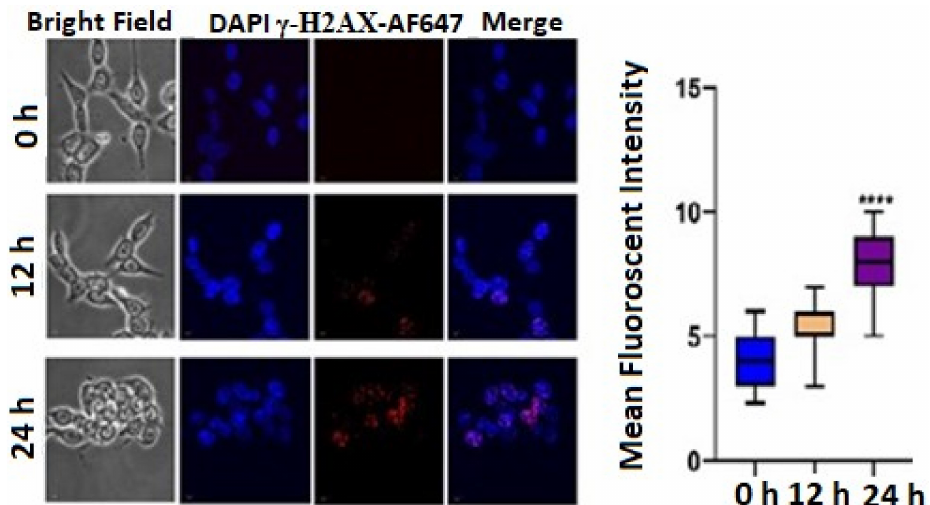
Figure 5. Immunofluorescence images showing qualitative expression of γ -H2AX expression after treatment with 3 µ g/mL TrzTFPPOP for 12 h and 24 h. Nucleus was counterstained with DAPI (magnification: × 60). Statistical mean fluorescence intensity plot is also added on right with respect to control, which is symbolized by ****.